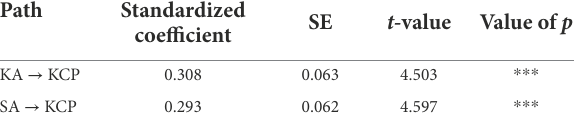
TABLE 10 Main effects path analysis.